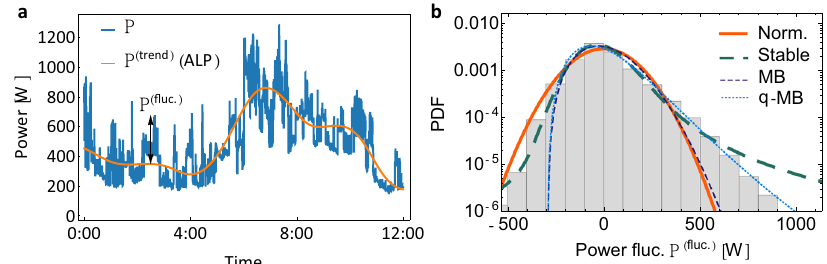
Fig. 4 The intermittent characteristic of power consumption fl uctuations. a The total power consumption P is a sum of the trend consumption P trend , obtained by the EMD method described in the previous section and fl uctuations P fl uc. . We record the difference between trend and real demand as the fl uctuation trajectory. For the purpose of clarity only a single day is shown here. b The probability density function (PDF) of the consumption fl uctuation does not follow a Gaussian distribution but is better described by a q -Maxwell – Boltzmann distribution, especially on the right fl ank. The histogram uses the whole NOVAREF dataset. Alongside the Gaussian, we show a stable and Maxwell – Boltzmann (MB) distribution. The q -Maxwell – Boltzmann parameters are determined by the methods of moments. See also Supplementary Note 4 for further details.